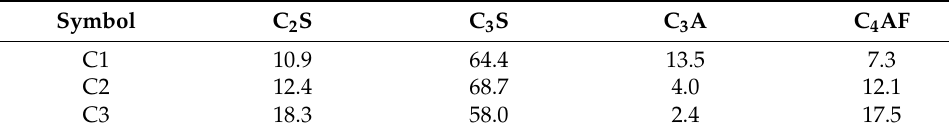
Figure 1. XRD analysis of GGBFS. ME—Merwinite; MO—Monticellite; L—Larnite; G—Gelhenite. Table 2. Phase composition of Portland clinkers, mass %.